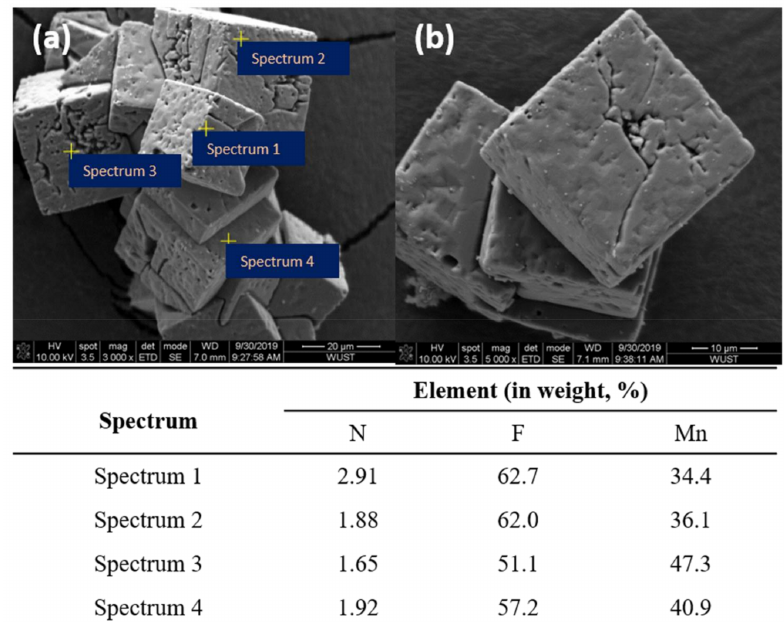
Figure 10. SEM-EDS analysis for the prepared impurity remover of MnNH 4 F 3 , ( a ) magnification × 3000, ( b ) magnification × 5000.